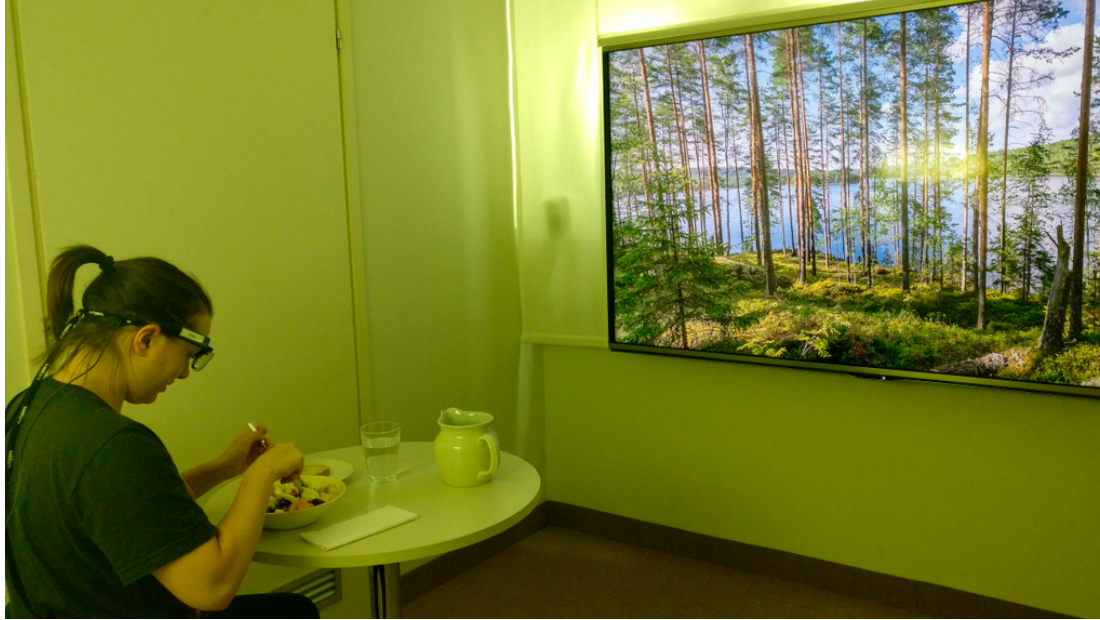
Figure 2. Lunch under a multisensory condition.